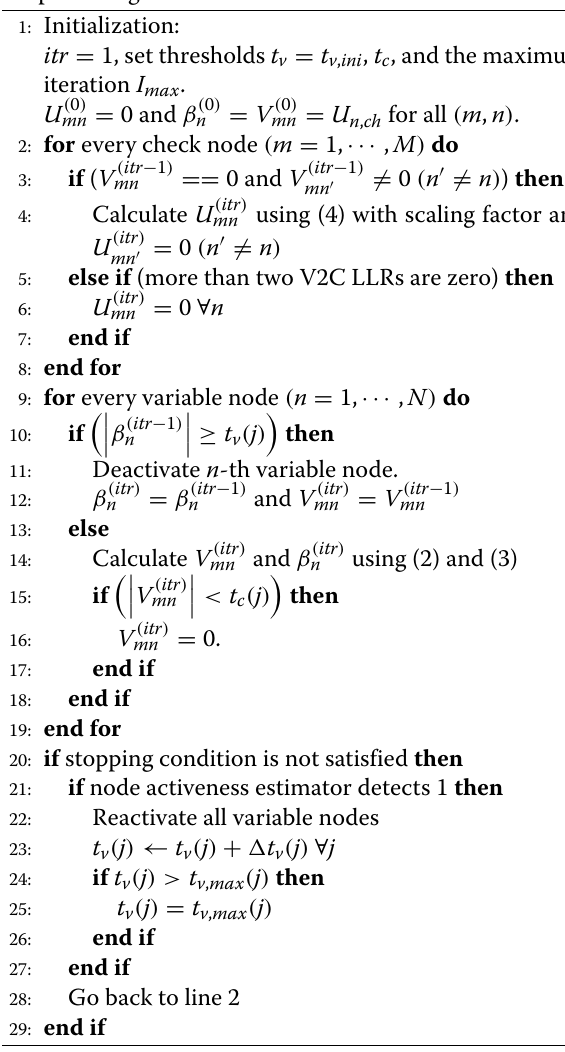
Algorithm 1 Normalized Min-sum Decoding with the Proposed